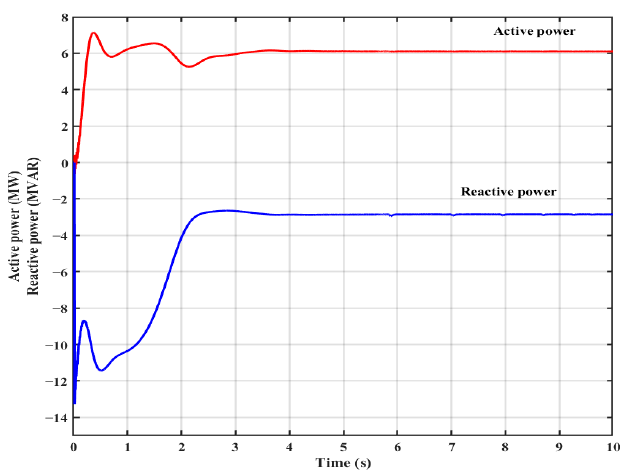
Figure 21. The PCC bus’s receipt of active and reactive power.